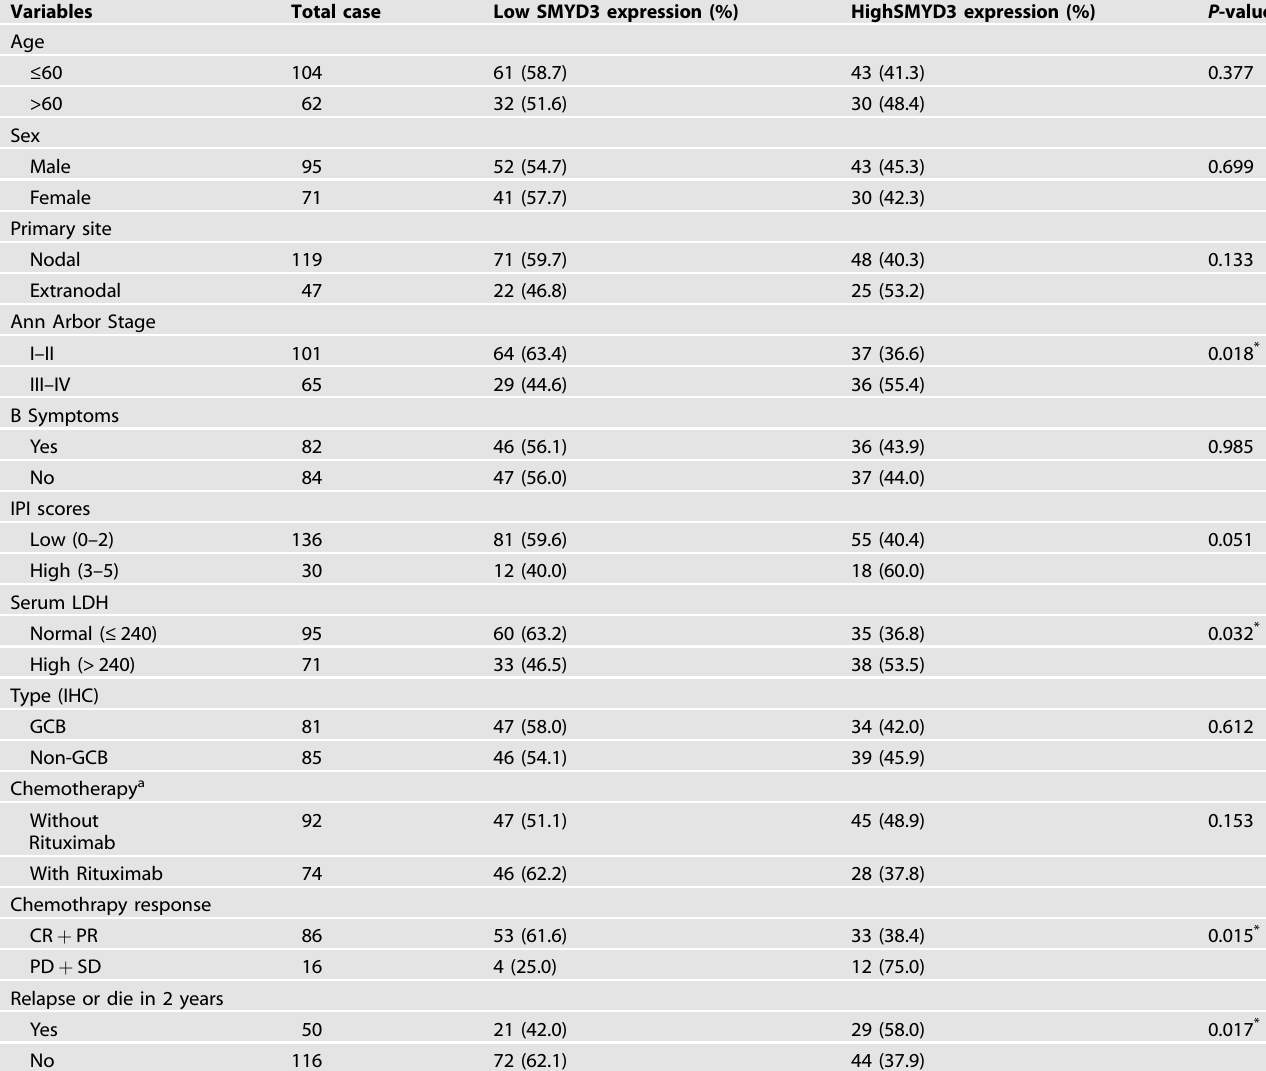
Table 1. Associations of SMYD3 protein expression with the clinicopathologic characteristics of